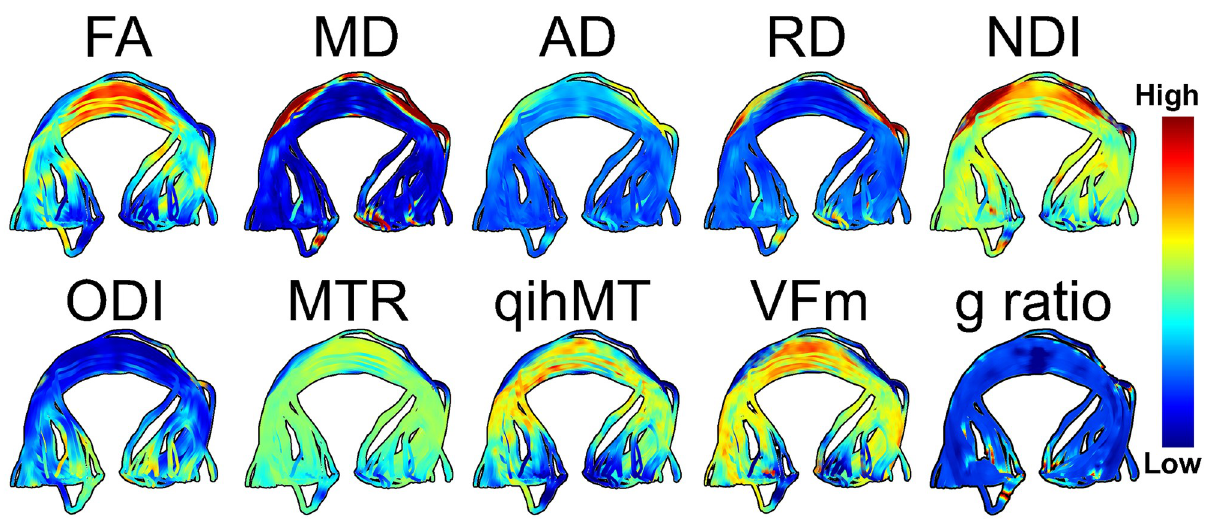
Fig 3. Multimodal imaging of white matter microstructure in the splenium. Measures from DTI, NODDI, MT, and mcDESPOT imaging can be contrasted to provide a multifaceted understanding of white matter structure.